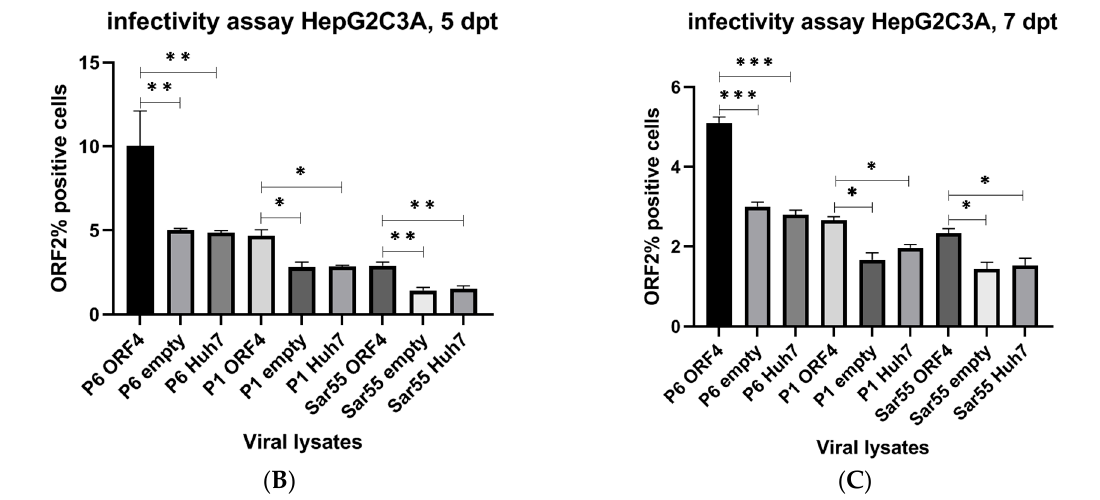
Figure 5. Presence of ORF4 from gt1 enhances gt3 HEV and gt1 HEV infectious titers. ( A ) Schematic representation of the workflow. HEV gt3 (P6 and P1) and gt1 (Sar55) transfected cells using duplicate cultures from the replication assay depicted in Figure 4 are lysed applying freeze and thaw cycles (3 times), centrifuged and supernatant harboring viral particles was collected and used to infect HepG2/C3A cells with equivalent lysate volumes. After 48 h, cells were passed 1:3 and incubated for 72 h. At 5 days post-infection (dpi), cells were harvested, fixed in 100% cold methanol, and quantified for ORF2-positive cells. ( B , C ) Flow cytometry quantification of HepG2/C3A cells infected with the supernatant from respective cell lysates (P6 ORF4, P1 ORF4, Sar55 ORF4, P6 empty, P1 empty, Sar55 empty, P6 Huh7, P1 Huh7 and Sar55 Huh7) performed at 5 dpi. Samples were fixed in cold methanol and probed with rabbit anti-ORF2 followed by goat anti-rabbit PE antibodies. Each bar (mean ± SEM) represents separate infections stained in parallel and display the mean of three independent biological experiments with nine replicates per sample (* p < 0.05, ** p < 0.01, and *** p < 0.001, t -test). Statistically significant difference exists between HepG2/C3A cell lines infected with equal volume of lysate from HEV gt3 (P6, P1) and gt1 (Sar55) strains from transfected cells expressing ORF4 verses infected cell lines not expressing ORF4.